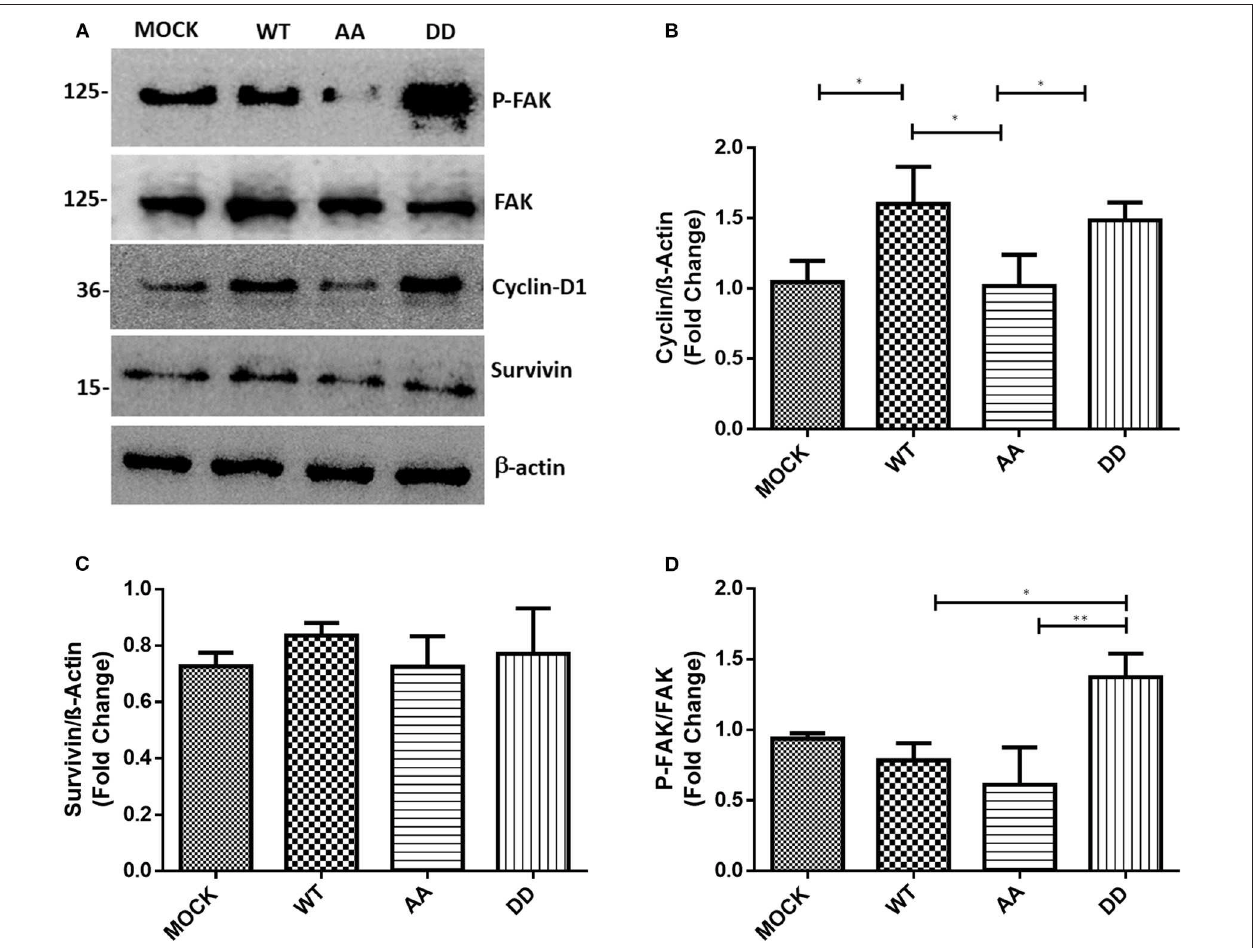
FIGURE 4 | Biphospho-mimetic ECE1c DD increases protein levels of cyclin-D1 and phospho-FAK. (A) DLD-1 cells overexpressing Flag-tagged ECE1c WT , ECE1c AA , or ECE1c DD proteins were grown for 24h under normal conditions and protein levels of phospho-FAK (P-FAK), FAK, cyclin-D1, and survivin were detected by Western blot using specific antibodies. Representative blots are shown. Relative β -actin-normalized levels of cyclin-D1 (B) and survivin (C) , and P-FAK/total FAK ratio (D) were quantified with ImageJ. Graphs represent mean ± SEM; * p < 0.05, ** p < 0.01.